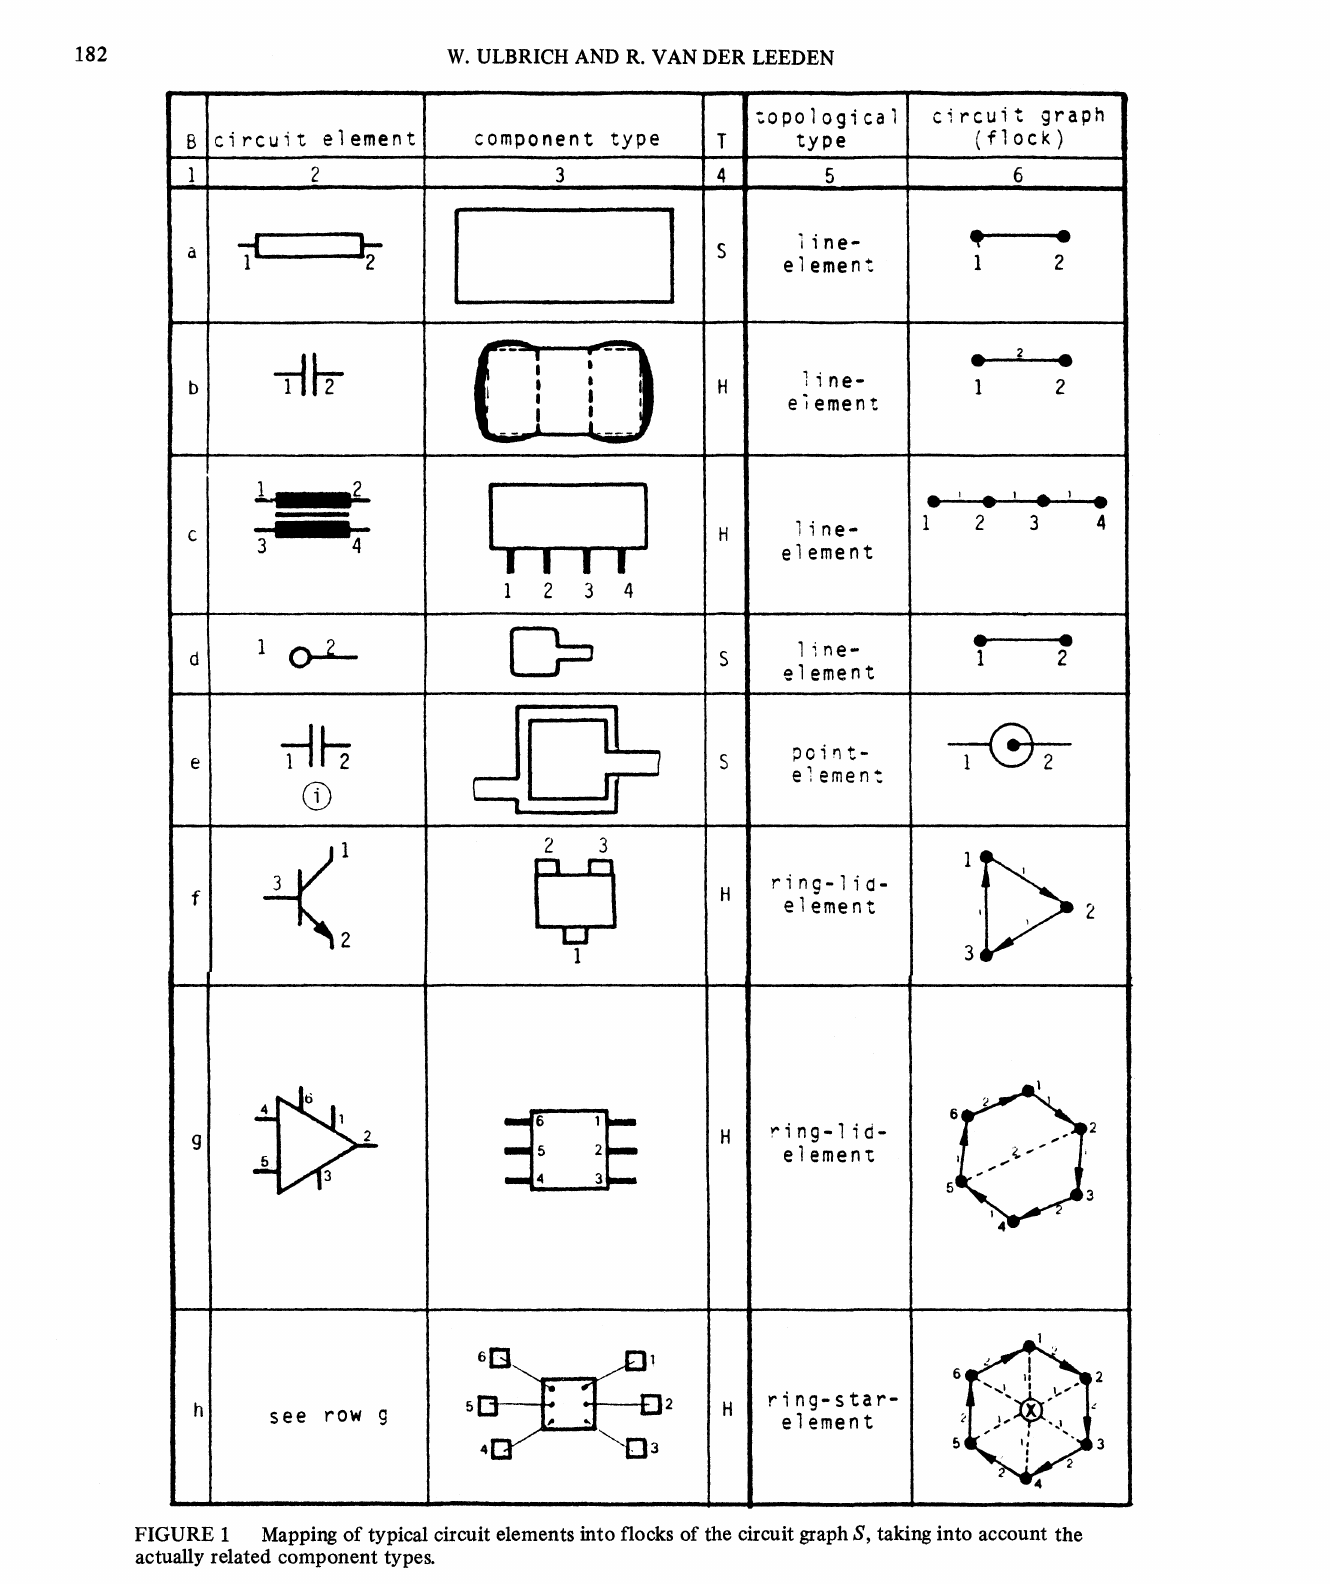
Mapping of typical circuit elements into flocks of the circuit graph S, taking into account the actually related component